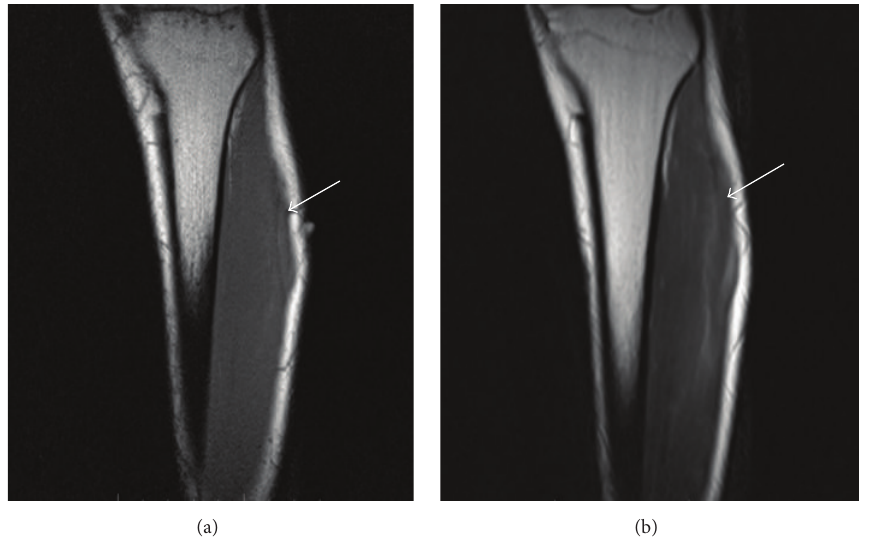
Figure 2: (a) Coronal section of left leg T1-weighted sequence showing defect at the level of the marker (marked by arrow) with outward bulging of underlying tibialis anterior through the defect. (b) Coronal section of left leg T2-weighted sequence outward bulging of tibialis anterior due to muscle herniation through the defect (marked by